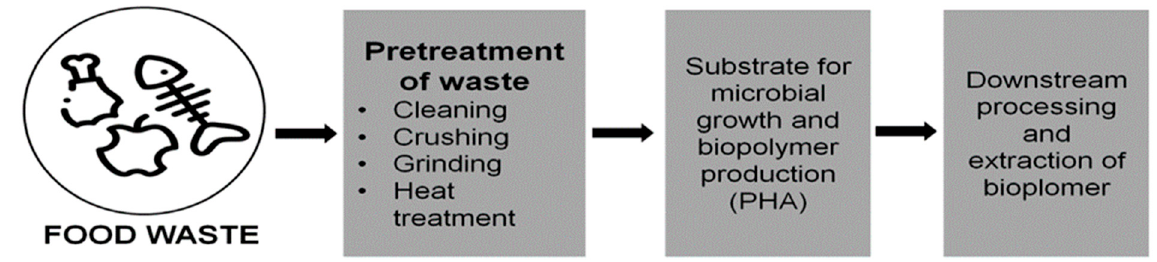
Figure 5. Production of bioplastic from food waste.